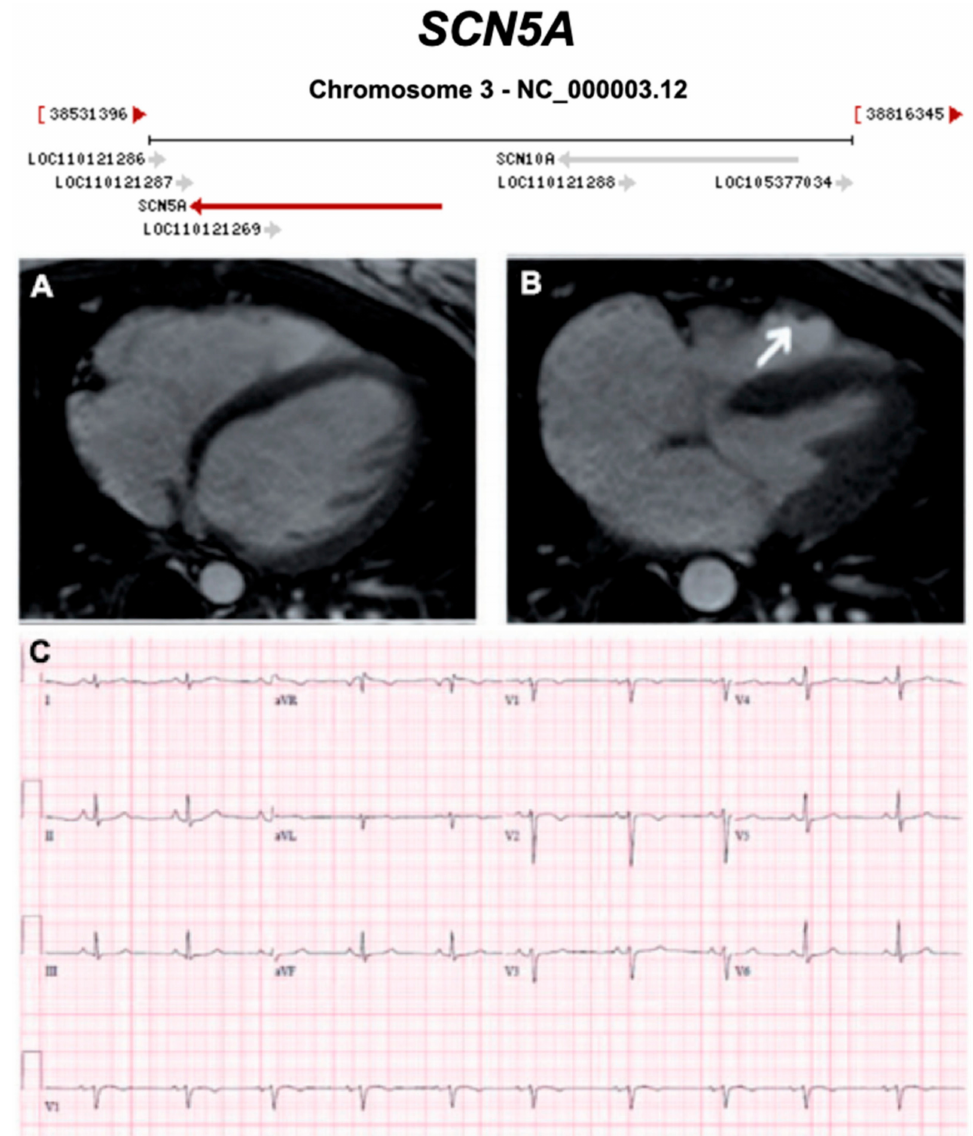
Figure 18. Exemplar MRI and ECG finding found in ACM patients with SCN5A mutations. ( A , B ) CMR of a female patient with SCN5A mutation (p.Arg1898His) showing end-diastolic and end-systolic state, respectively. The white arrow shows an enlarged right ventricle and dyskinesia in the RV outflow tract; ( C ) a 12-lead ECG of the same patient showed T-wave inversion in V1–2. Reproduced with permission from te Riele et al. (2017)